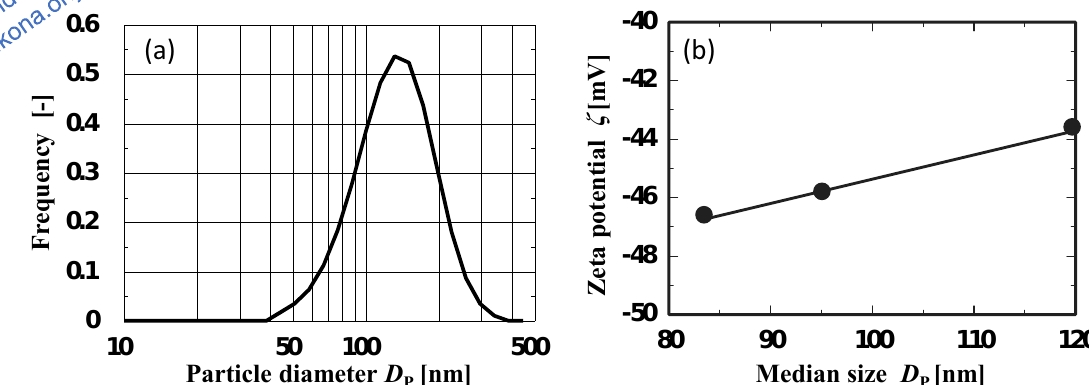
Fig. 1 Properties of the tested silica particle: (a) size distribution; (b) zeta potential with median size.